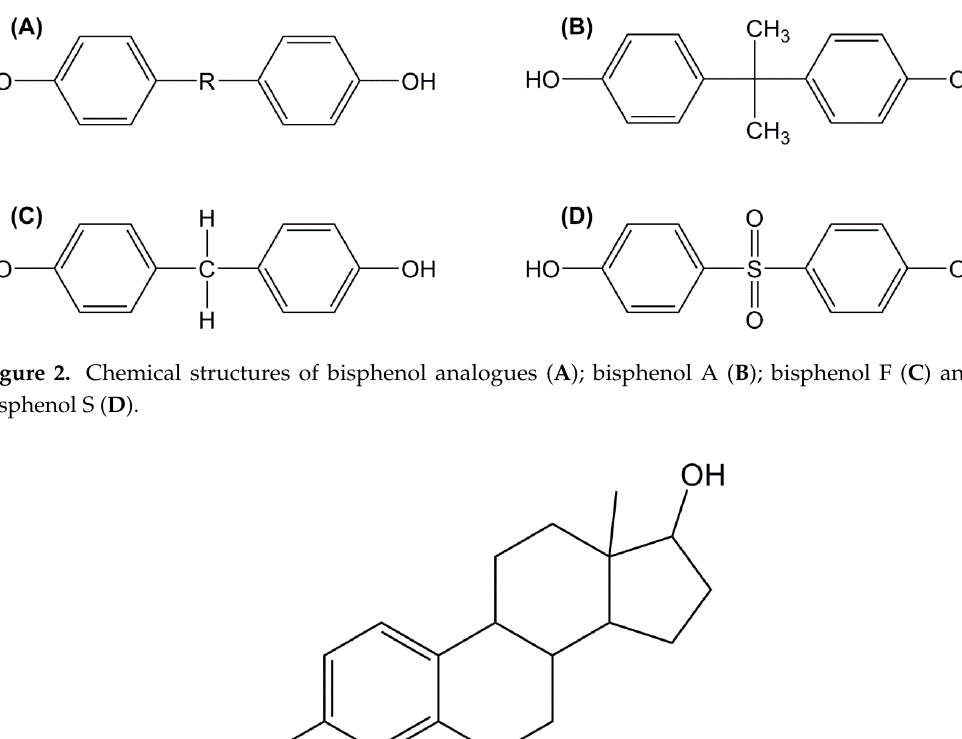
Figure 2. Chemical structures of bisphenol analogues ( A ); bisphenol A ( B ); bisphenol F ( C ) and bisphenol S ( D ).